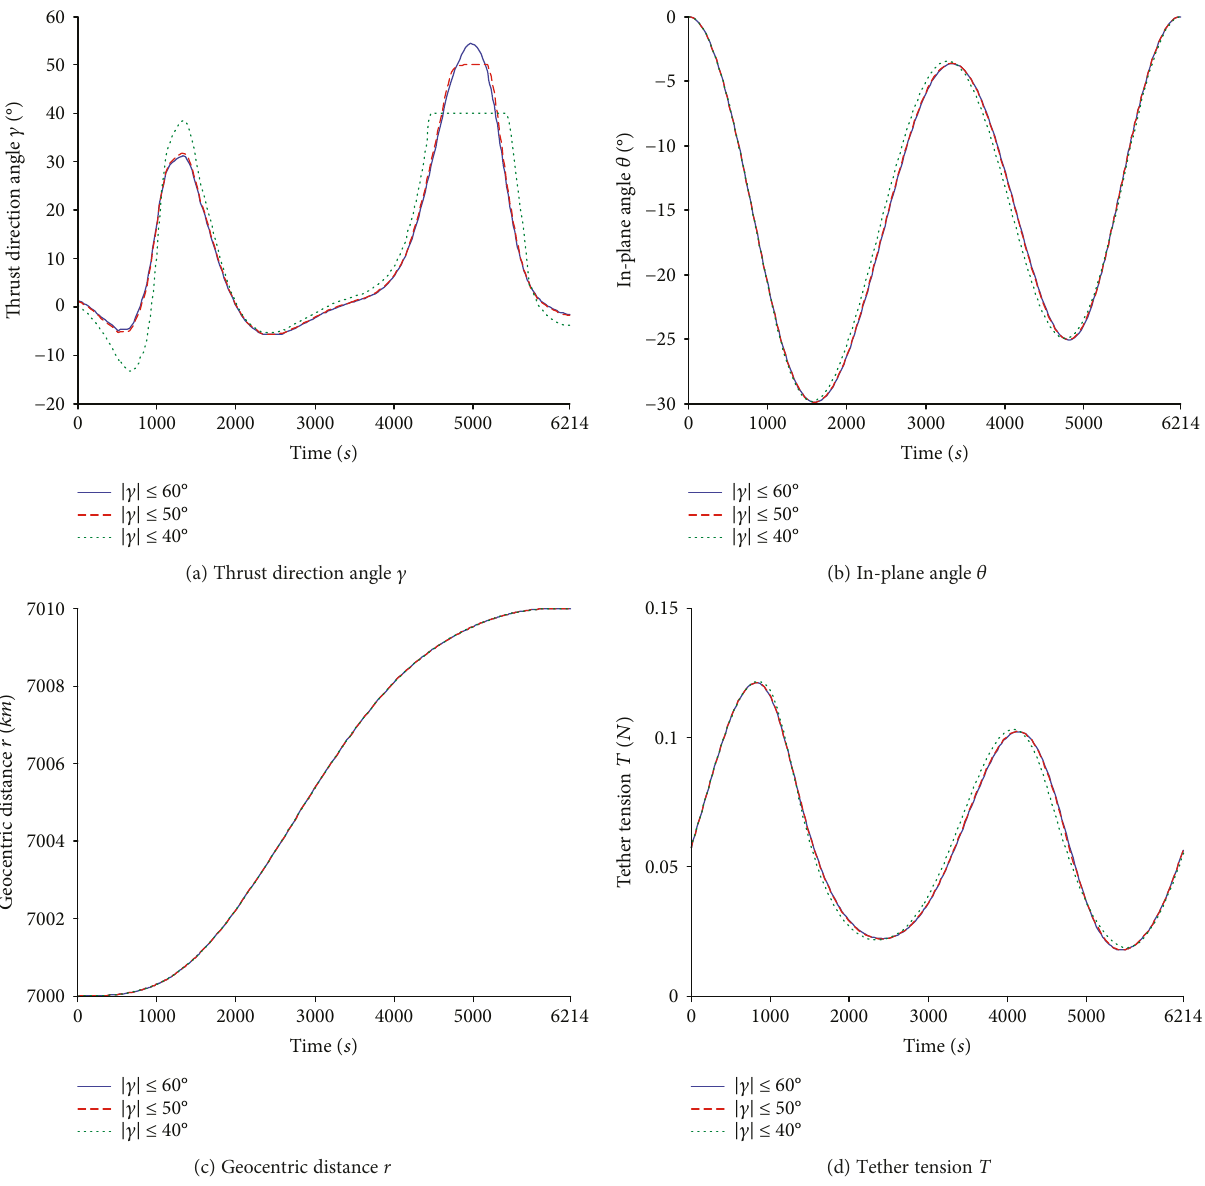
Figure 5: Time responses of the tethered system with di ff erent constraints on γ